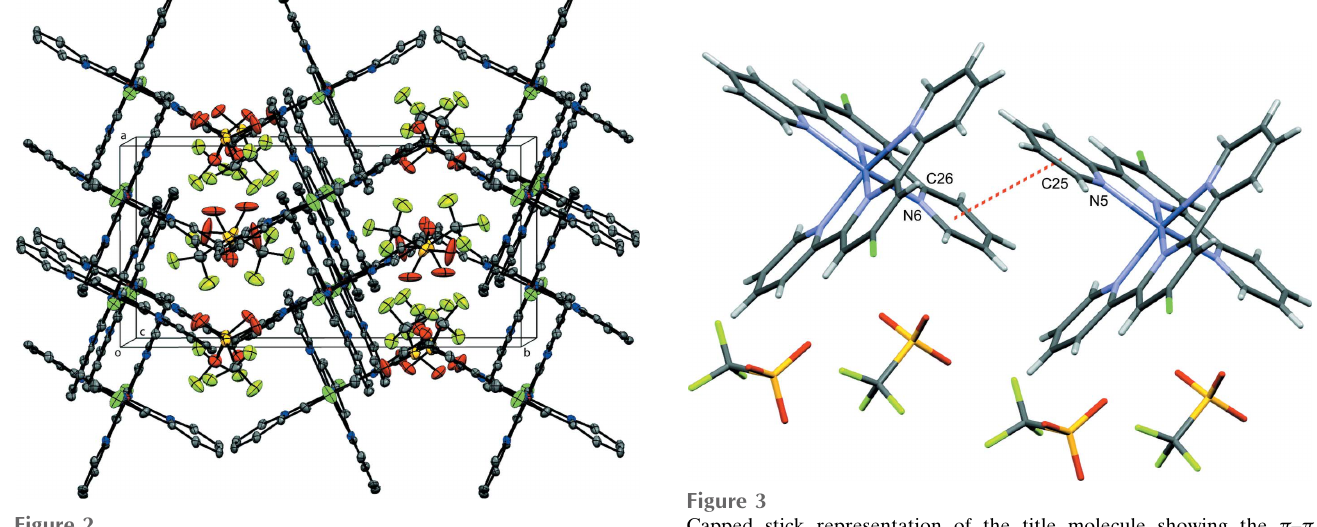
Figure 2 Packing for the title complex; H atoms are omitted for clarity.